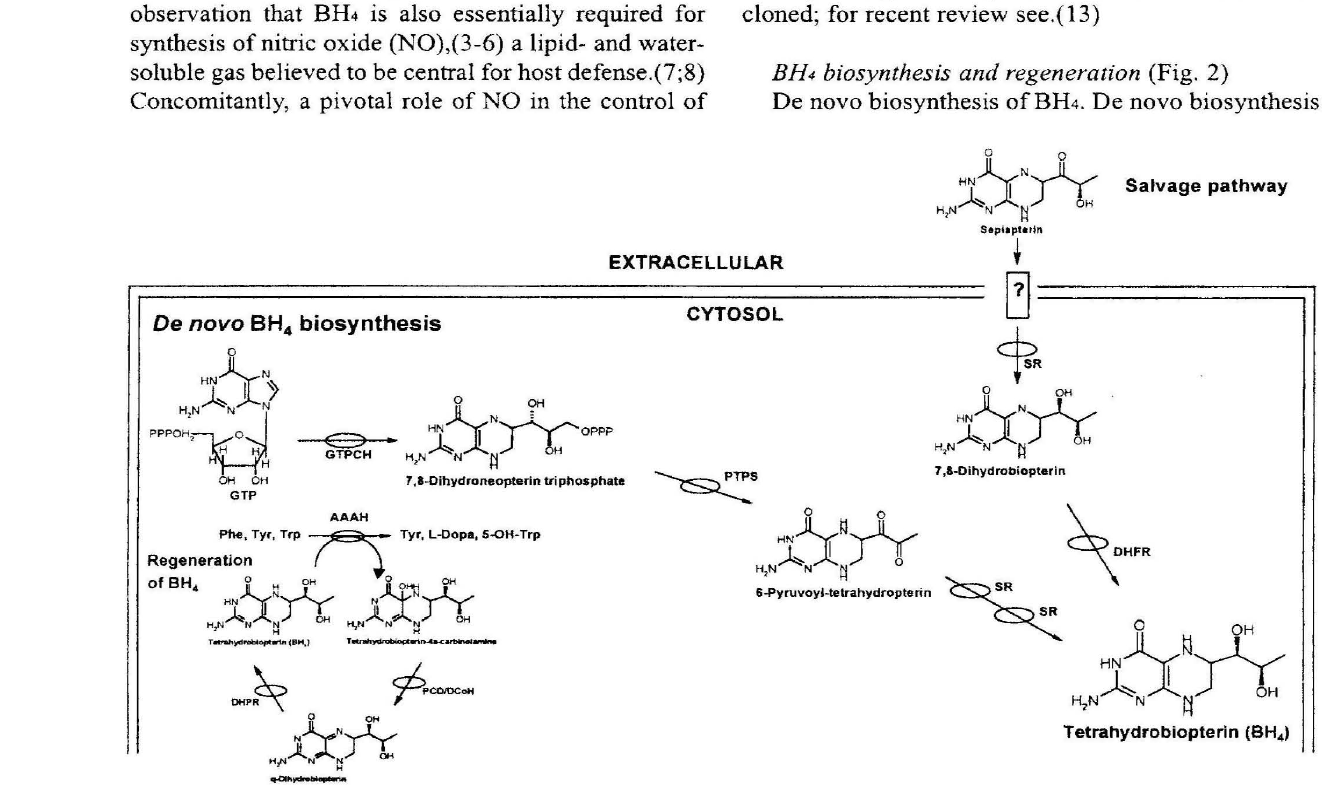
Figure 2. BH4 biosynthesis, salvage pathway, and regeneration. See text for details. De novo biosynthesis starts from GTP. Sepiapterin is not synthesized in mammalian cells, but is taken up by an yet unknown mechanism. BH4 oxidized during aromatic amino acid hydroxylation is recycled by a separate enzyme system. Abbreviations: AAAH, aromatic amino acid hydroxylase; DHFR, dihydrofolate reductase; DHPR, dihydropteridine reductase; GTPCH, GTP cyclohydrolase I; PCDIDCoH, pterin-4a-carbinolamine dehydratase; PTPS, 6-pyruvoyl-tetrahy dropterin synthase; SR, sepiapterin